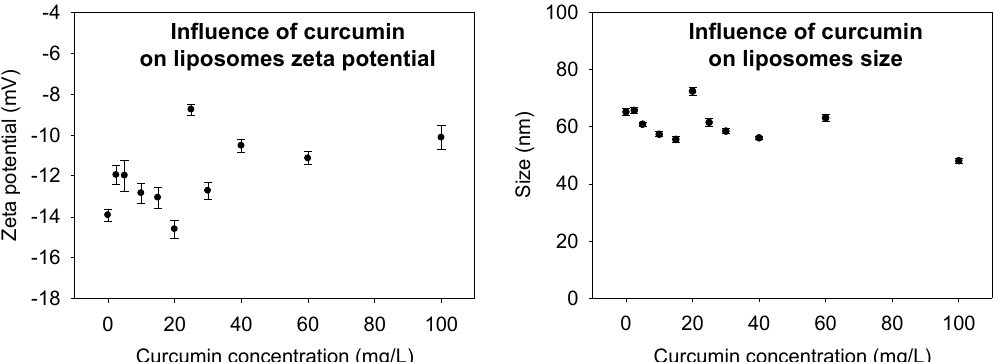
Figure 3. Evaluation of size and ζ -potential of liposome at different concentrations of encapsulated Figure3. Evaluationofsizeand ζ curcumin.